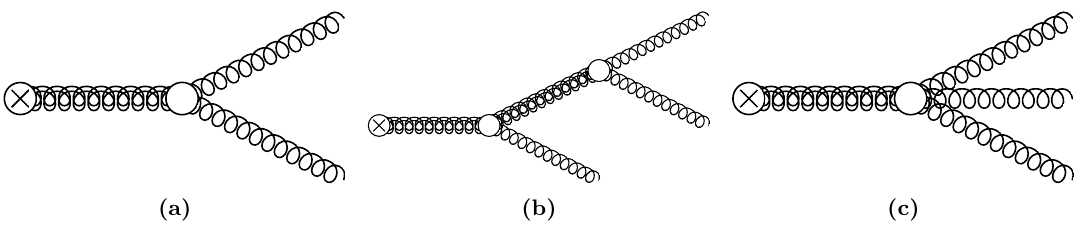
Figure 1. Diagrammatic representation of the first two nontrivial orders of the evolved gauge field’s expansion in the coupling g 0 from (2.13). (a) represents B µ, 1 from (2.14), (b) collectively represents the first two terms in B µ, 2 from (2.14), and (c) represents the last term in B µ, 2 from (2.14). In this notation, double lines stand for kernels (‘exponentials-of-Laplacian’) together with a flow time integration, white blobs represent GF vertices, black blobs are the usual QCD vertices, and the crossed blobs are the external